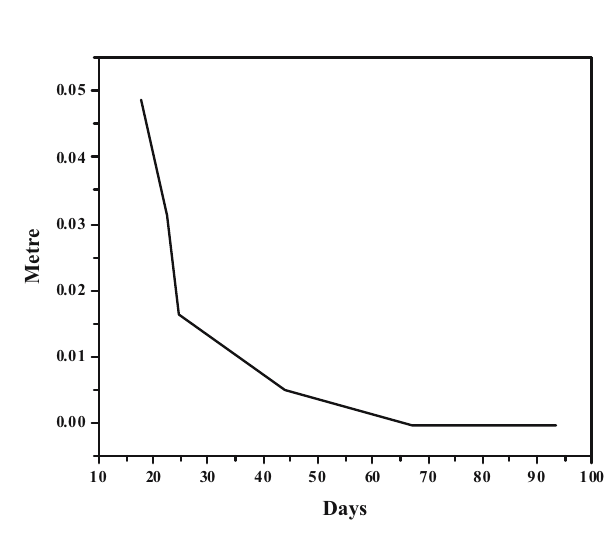
Figure 4: Communication